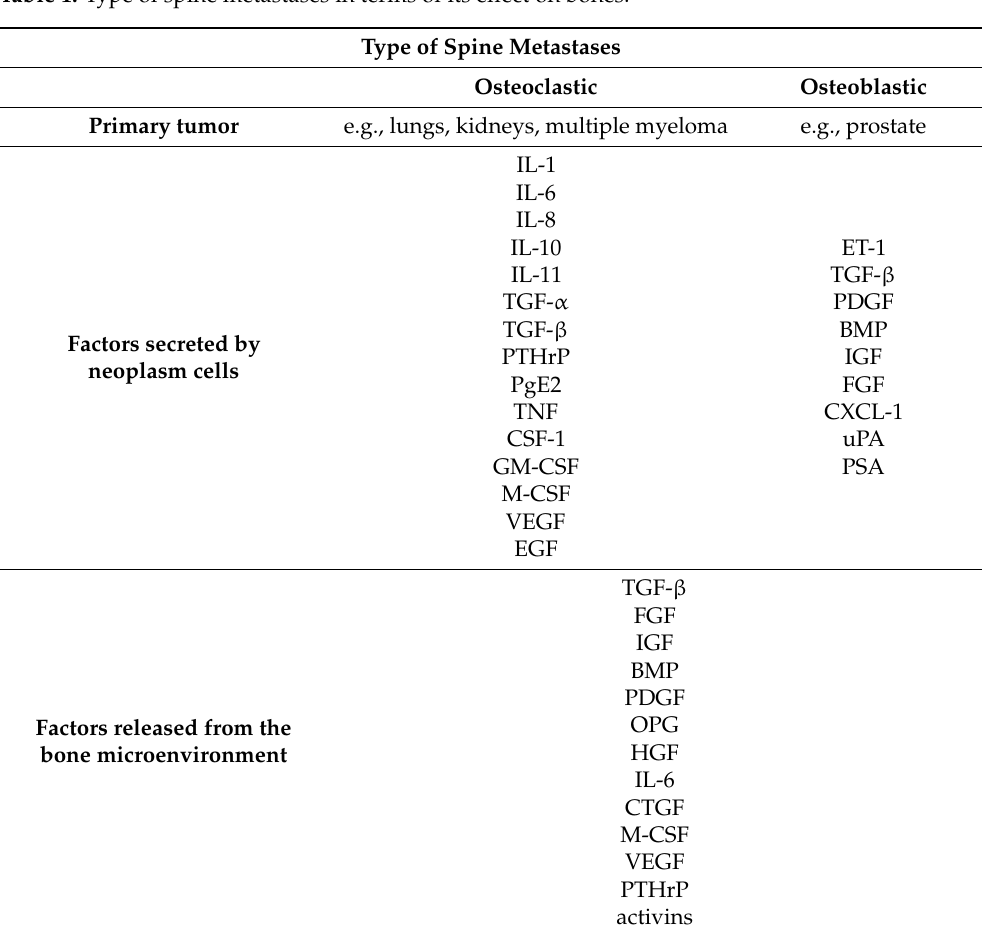
Table 1. Type of spine metastases in terms of its effect on